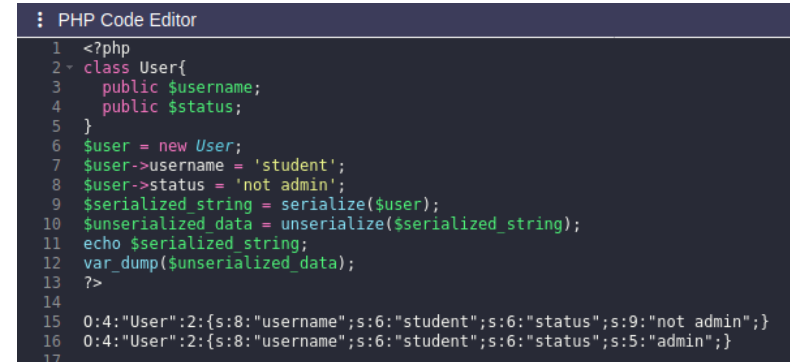
Figure 7. Exercise 7.3: Unprotected Object Deserialization (⋆)